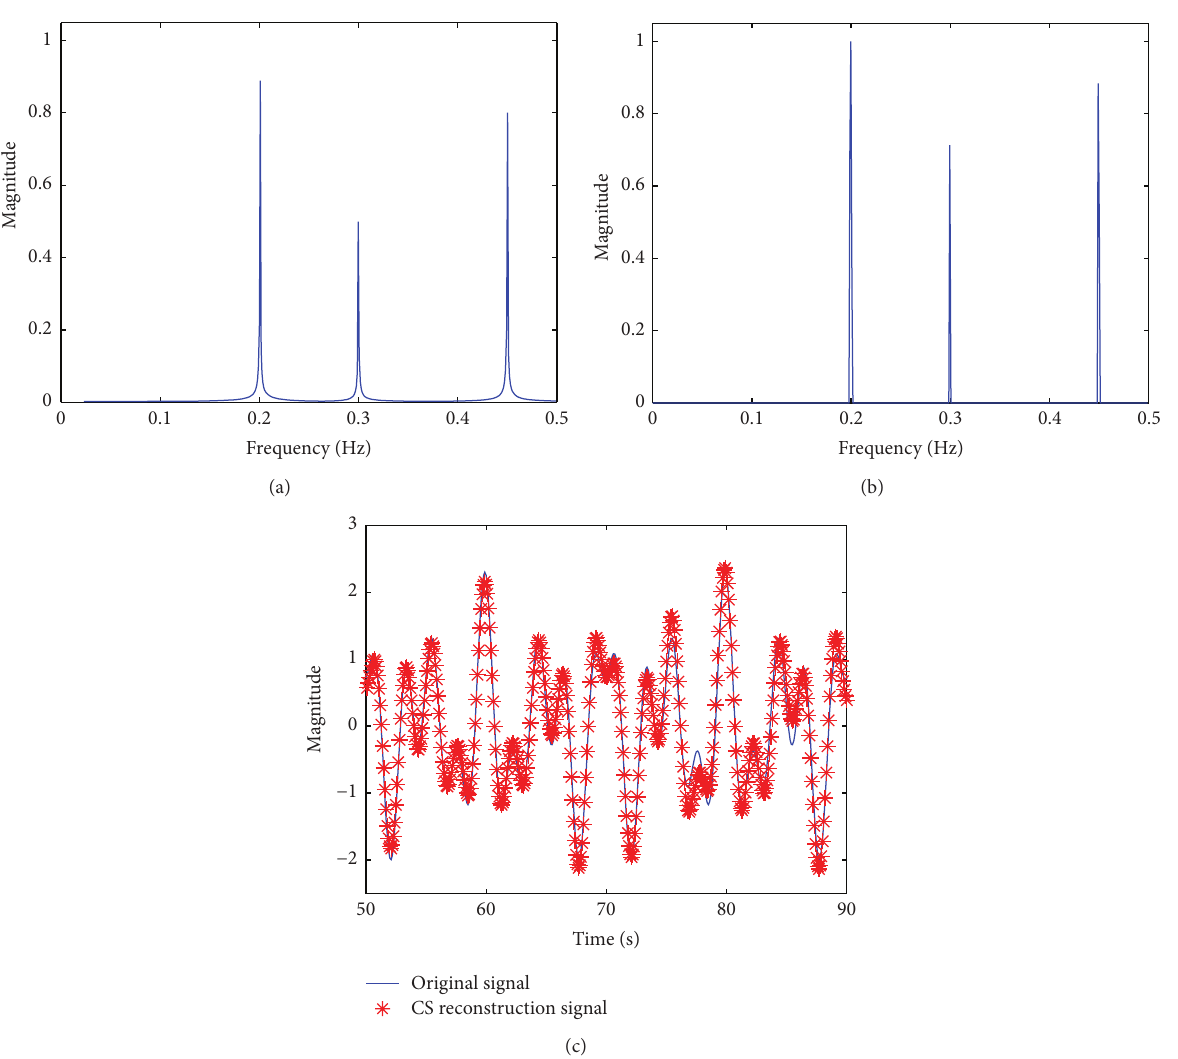
Figure 2: Experiment for validation of Theorem 3. (a) The spectrum of the signal 𝑥(𝑡) with Nyquist sampling rate; (b) the spectrum of the reconstructed signal by CS; (c) the comparison of 𝑥(𝑡) and the reconstructed signal in time